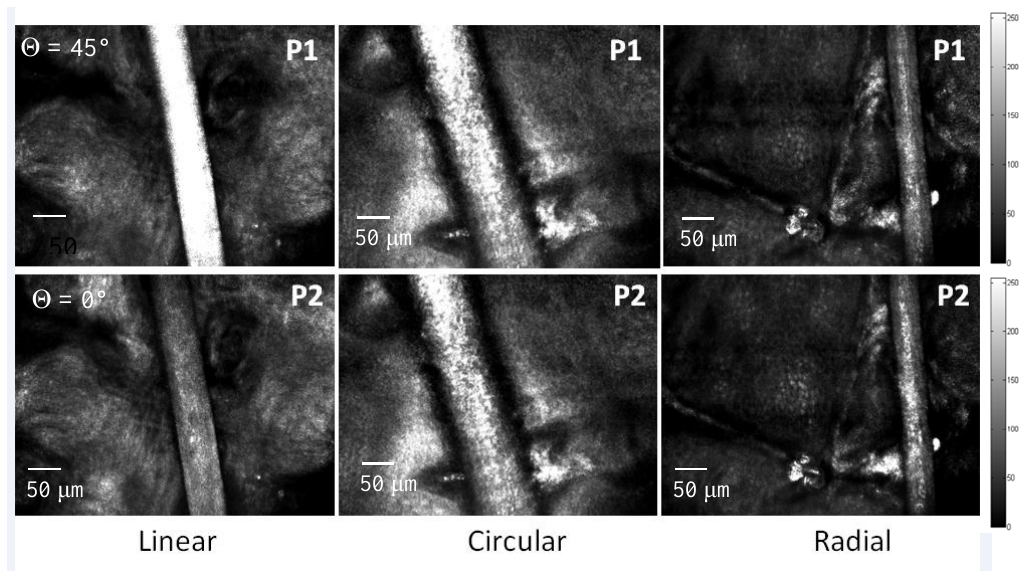
Figure 3. CP-CLSM images of non-medullated hair and skin ( in-vivo ) measured with linear, circular and radial polarizations for two orientations of the incident polarization (P1 and P2).